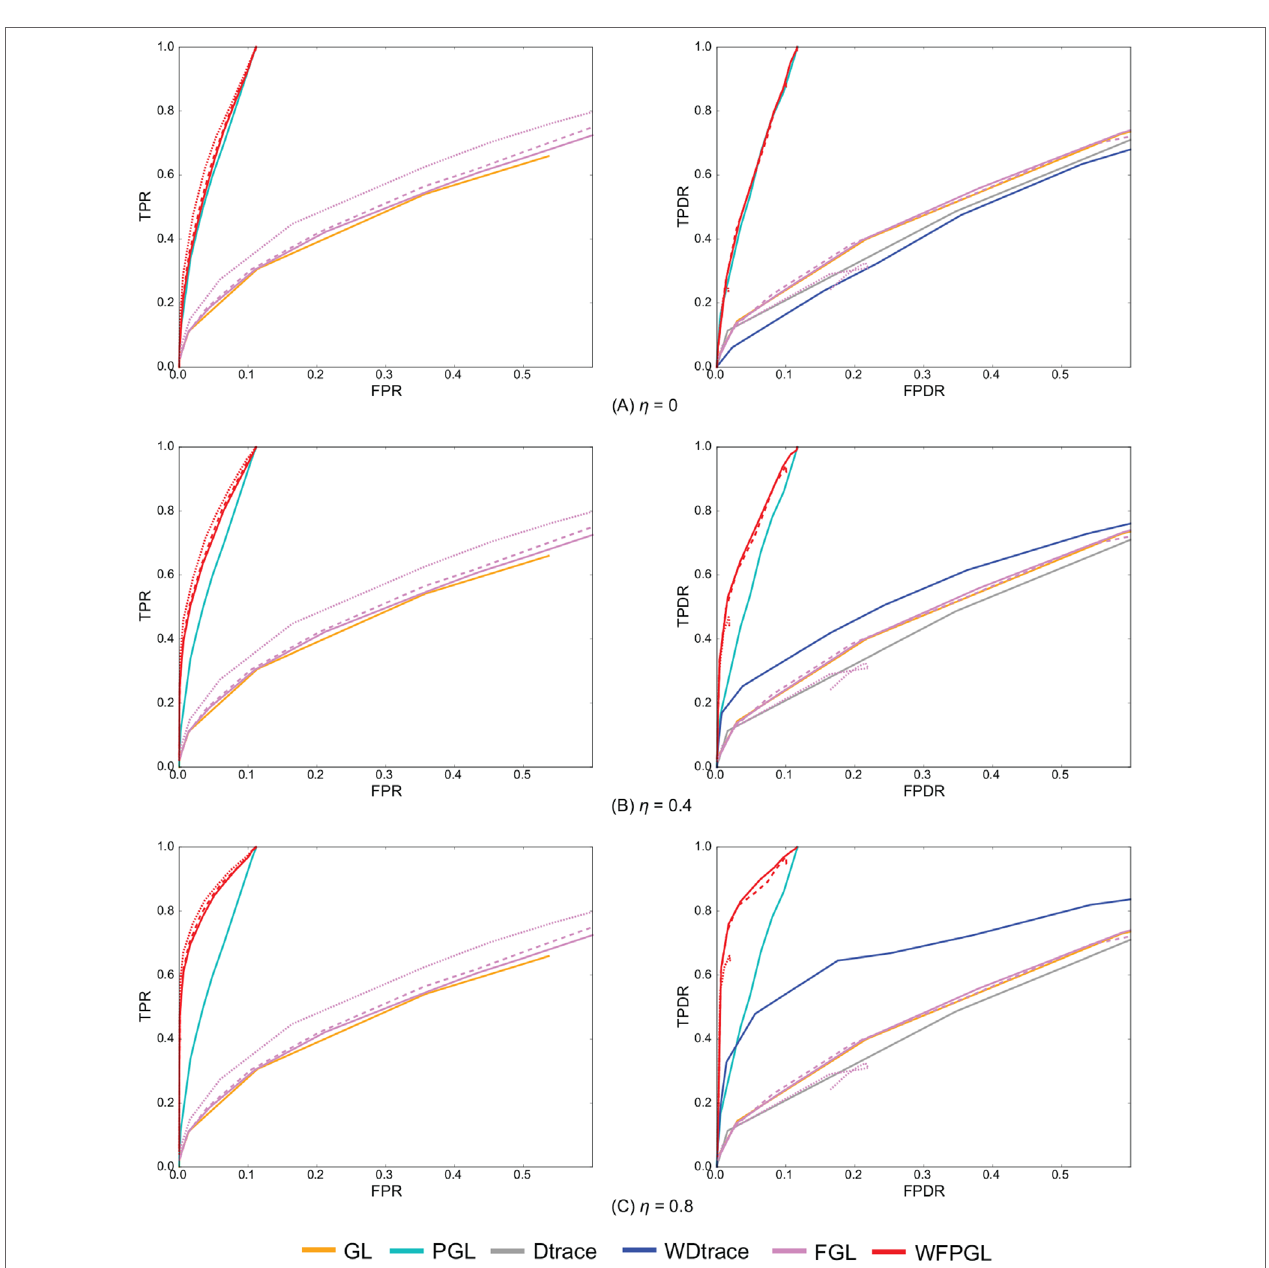
FIGURE 2 | The experiment results of various methods on two groups of samples, with the value of η changing at (A) η = 0, (B) η = 0.4, and (C) η = 0.8. The performance of various methods on individual network estimation [with respect to true-positive rate (TPR) and false-positive rate (FPR)] is shown on the left side, while the performance of various methods on differential network estimation [with respect to true-positive differential rate (TPDR) and false-positive differential rate (FPDR)] is shown on the right side. For weighted fused pathway graphical lasso (WFPGL) and fused graphical lasso (FGL), different line styles correspond to different choices of λ 2 : solid line for λ 2 = 0.0001, dashed line for λ 2 = 0.001, and dotted line for λ 2 =